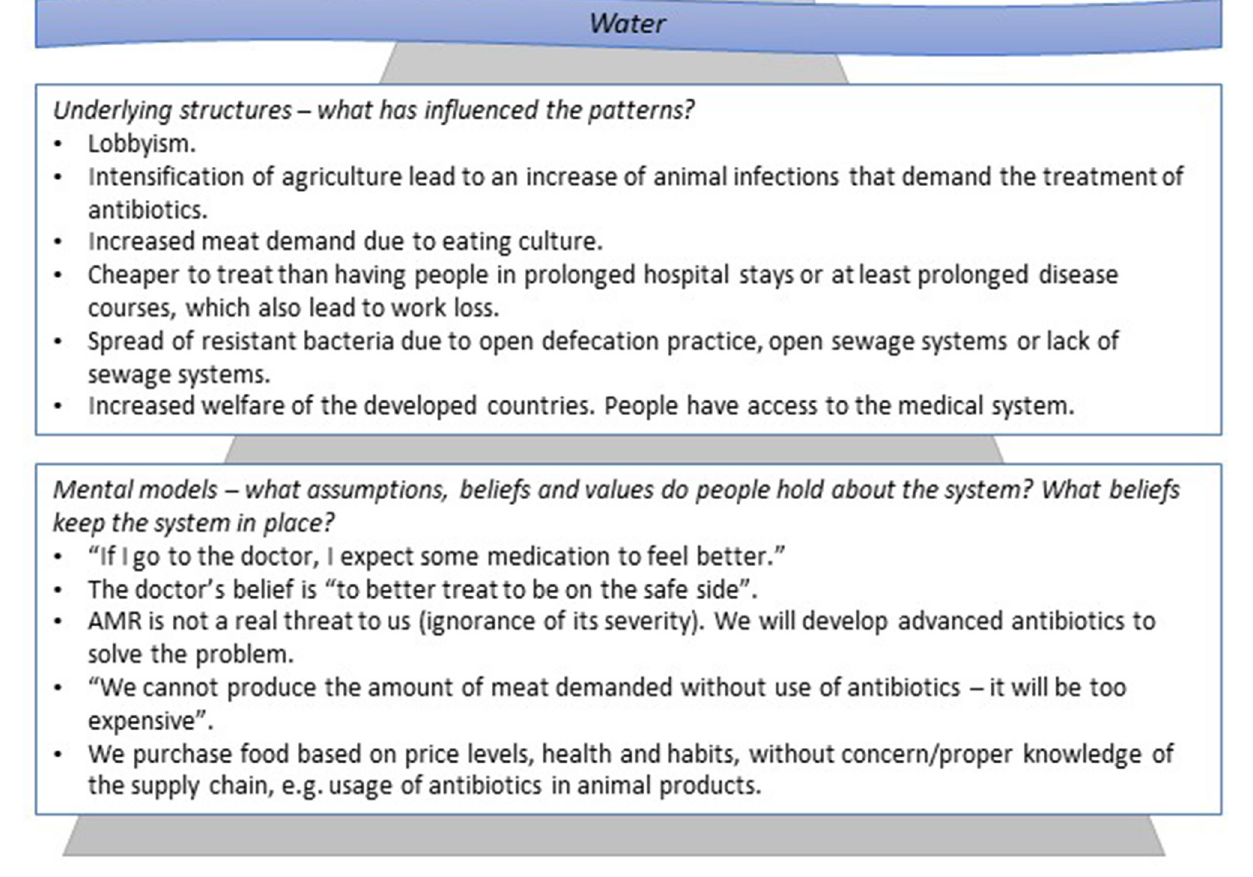
FIGURE 5 | Iceberg model of present AMR system. On the top, visibly, the events and patterns of the present AMR system. Under the water surface, hidden, the system structure and on the bottom peoples’ underlying assumptions, beliefs, and values (mental model). The upper part is supposed to be influenced by the one below, meaning the system structure is caused by the mental models. The model is applied lightly in this context to give an overview of the different levels and to provide a contextual application of the system map around the “water level.” To truly see the depth of the AMR problem, the iceberg model could be explored much more deeply to enter into the mental models that undercut all of society as we know it (e.g., life and death). However, this becomes a philosophical exercise and is outside of the focus of this research.